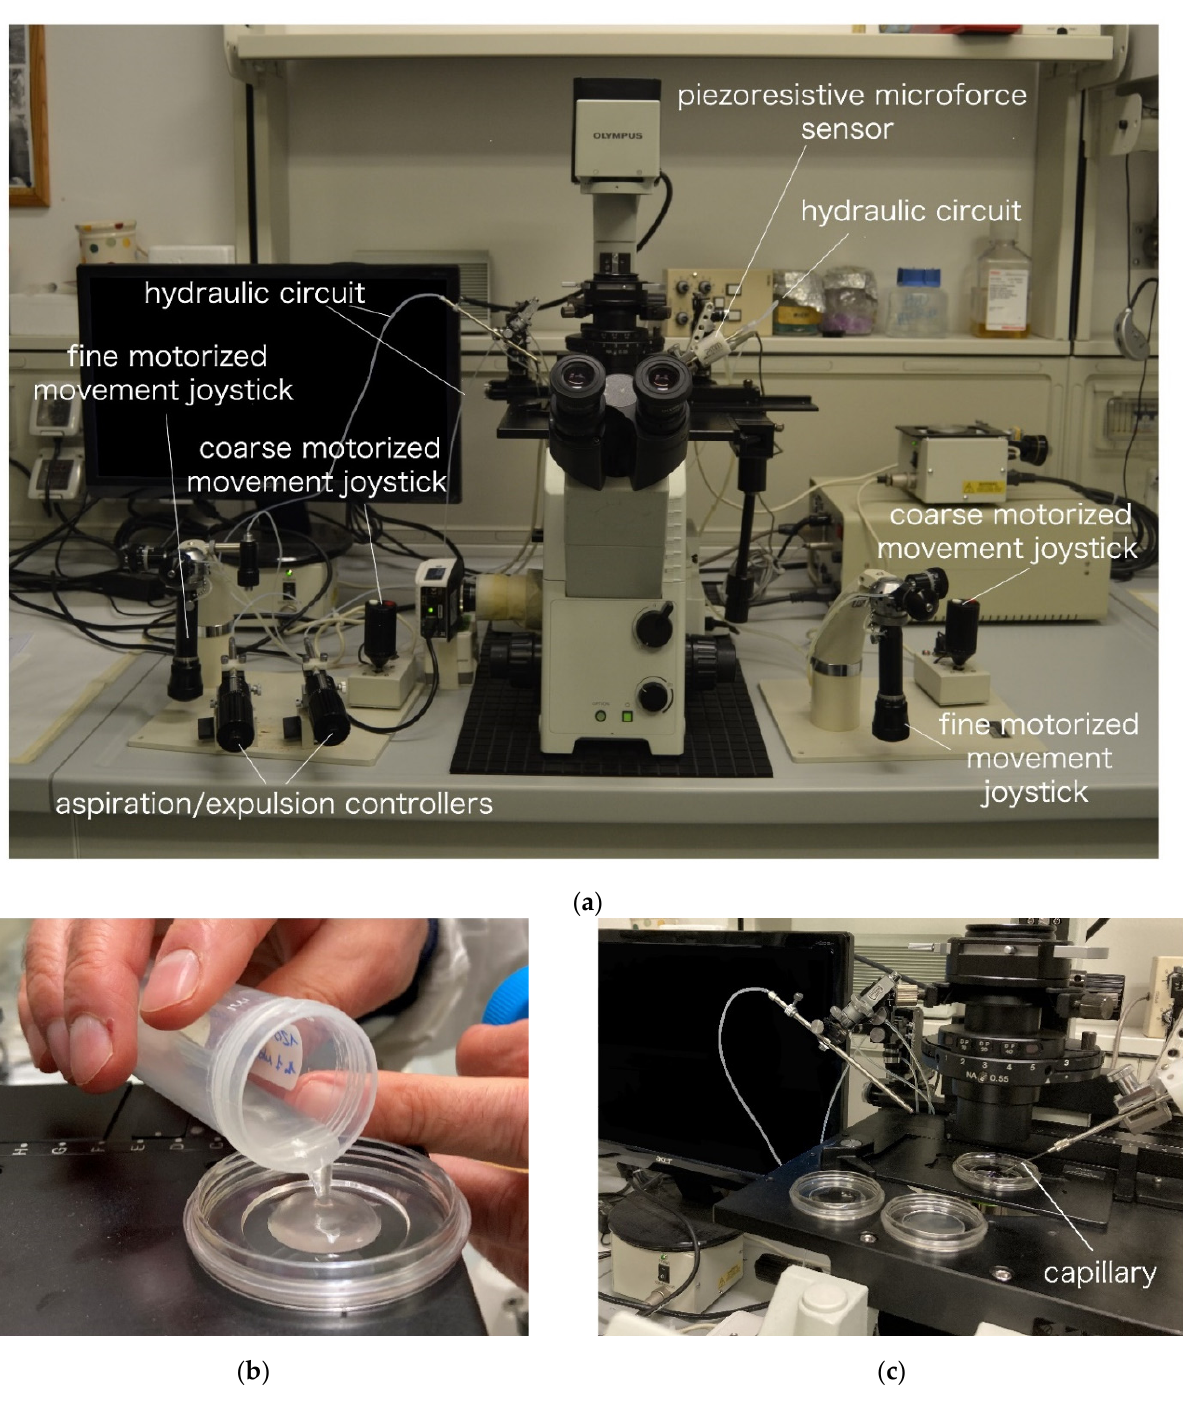
Figure 2. Micromanipulator and microscope settings together with sample placement before the picking: ( a ) Micromanipulator Narishige MF-9 maneuvered with a hydraulic circuit and inverted microscope Olympus IX71. The key parts of the instrumentation are specified; ( b ) Pouring of the drop of suspension containing diluted sediment from ODP Site 1209B into the Petri dish; ( c ) Details of the micromanipulator and microscope settings showing the allocation of the capillary and Petri dish with the drop of sediment